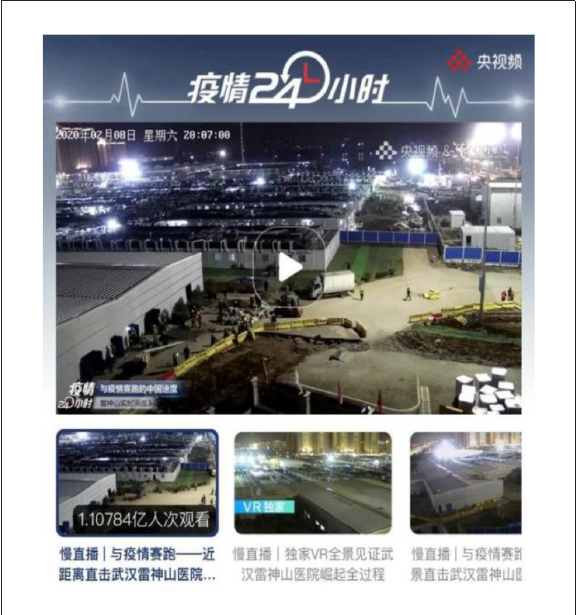
FIGURE1 Screenshot of the 24H-LS playing interface of CCTV’s online platform during the construction of Huoshenshan cabin